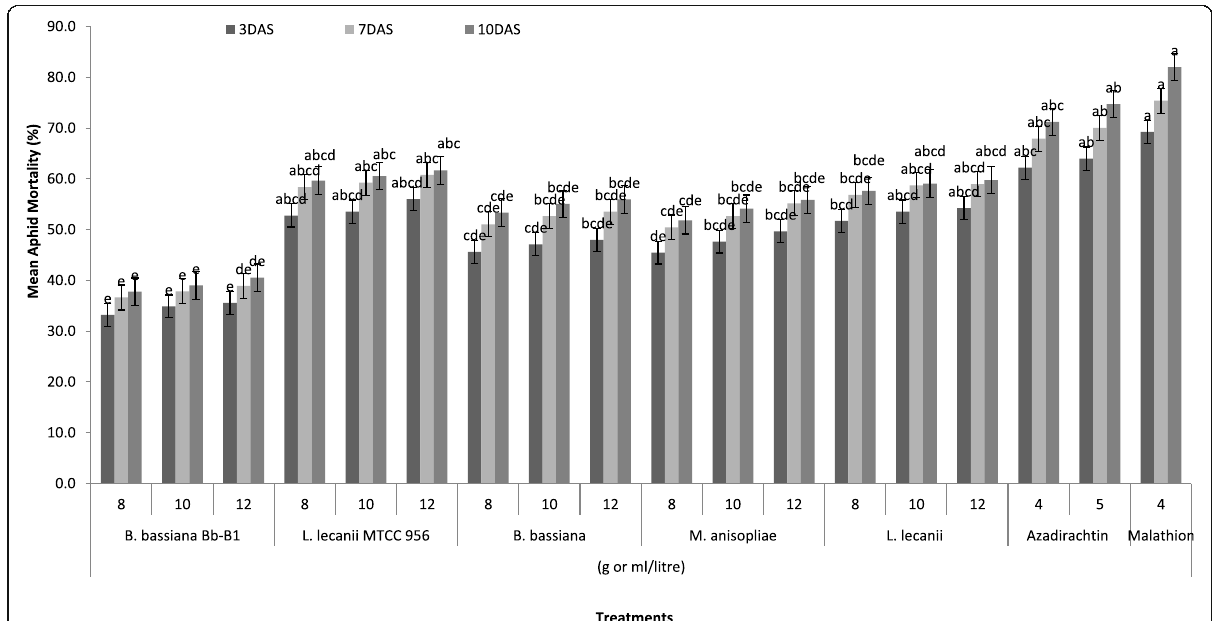
Fig. 1 Mean mortality (%) ± SE of M. persicae recorded at different time intervals ( DAS days after spray). Treatment columns bearing different alphabets are significantly different from other treatments according to Duncan test ( P =